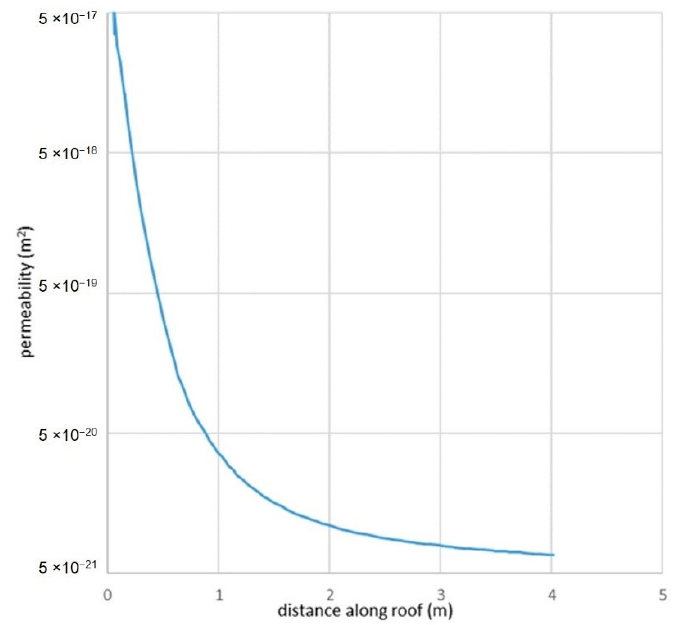
Figure 15. Simulated permeability profile along TSX roof.